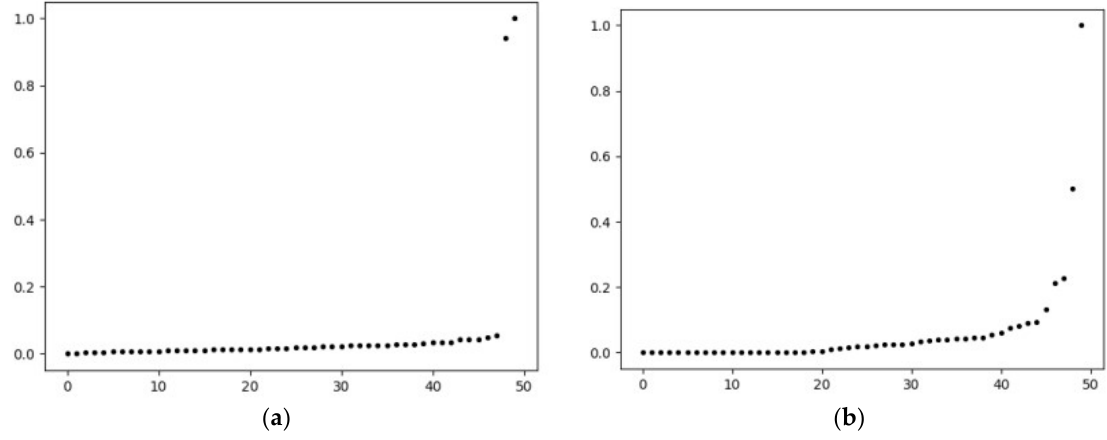
Figure 6. γ scatter plot ( n = 50). (a) γ scatter plot of data1; (b) γ scatter plot of data2. The F-DPC algorithm uses the DPC algorithm to cluster data1 and data2 according to the found cluster centers and numbers, and then fuses them according to the fusion